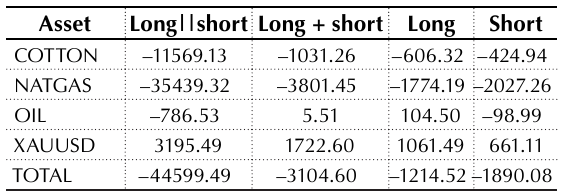
Table 4. Sums of profits during the 79 week period for Expert Advisors running with optimized parameters (by means of the d-Backtest PS method)